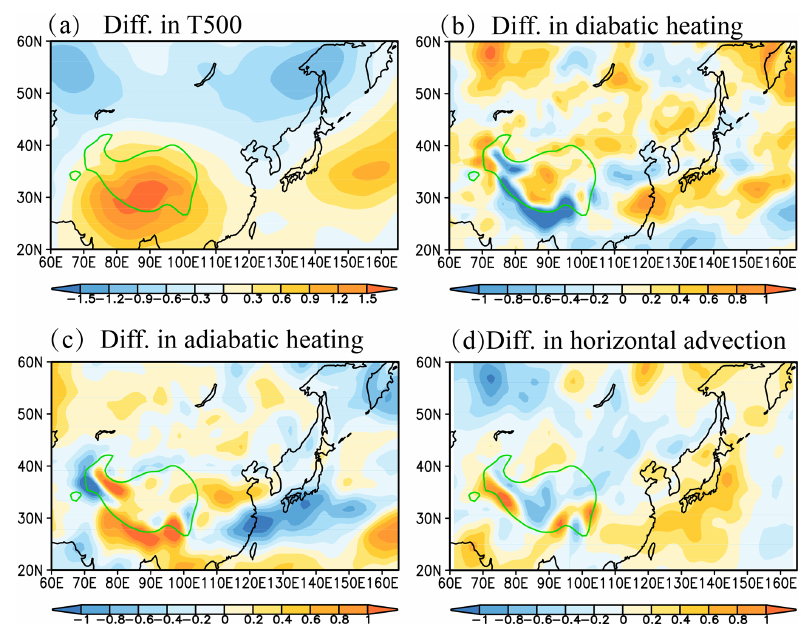
Figure 8. Spatial distribution of the MAM composite difference between the strongest and weakest TPSH years (strongest–weakest) for the model in (a) the atmospheric temperature at 500hPa ( ◦ C), (b) the diabatic heating at 500hPa (Kd − 1 ), (c) the adiabatic heating at 500hPa (Kd − 1 ), and (d) the horizontal temperature advection at 500hPa (Kd − 1 ). The green-contour area indicates the plateau above 2500m.